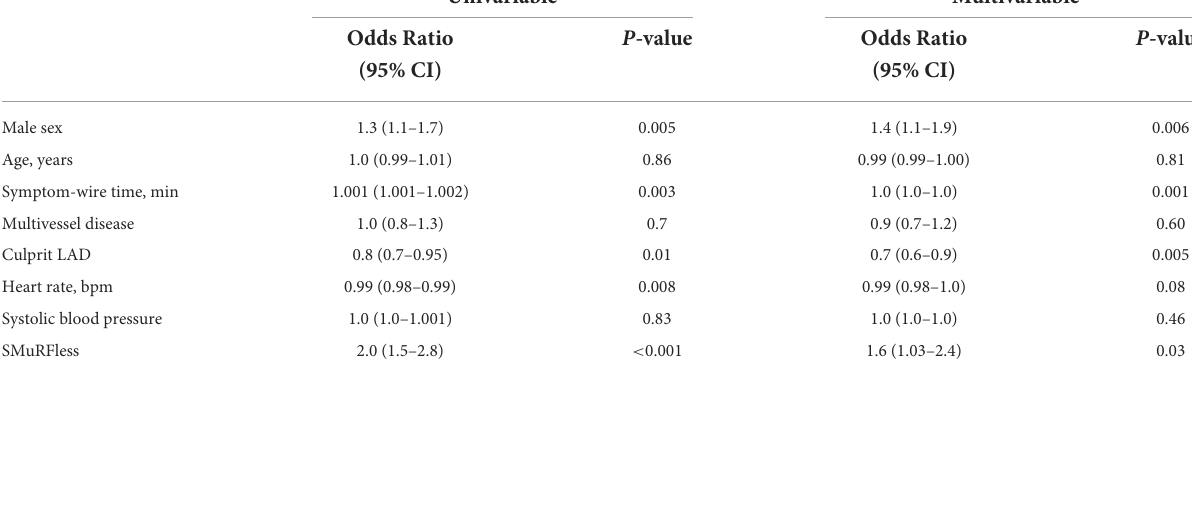
TABLE 5 Uni and multivariable logistic regression analysis for predictors of TIMI 0-1 flow